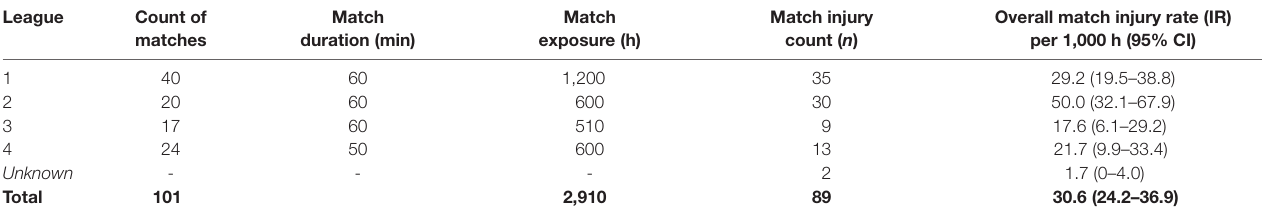
TABLE 1 | Koshuis 2018 season match count, duration, exposure and number of time-loss injuries and incidence rates, by league.